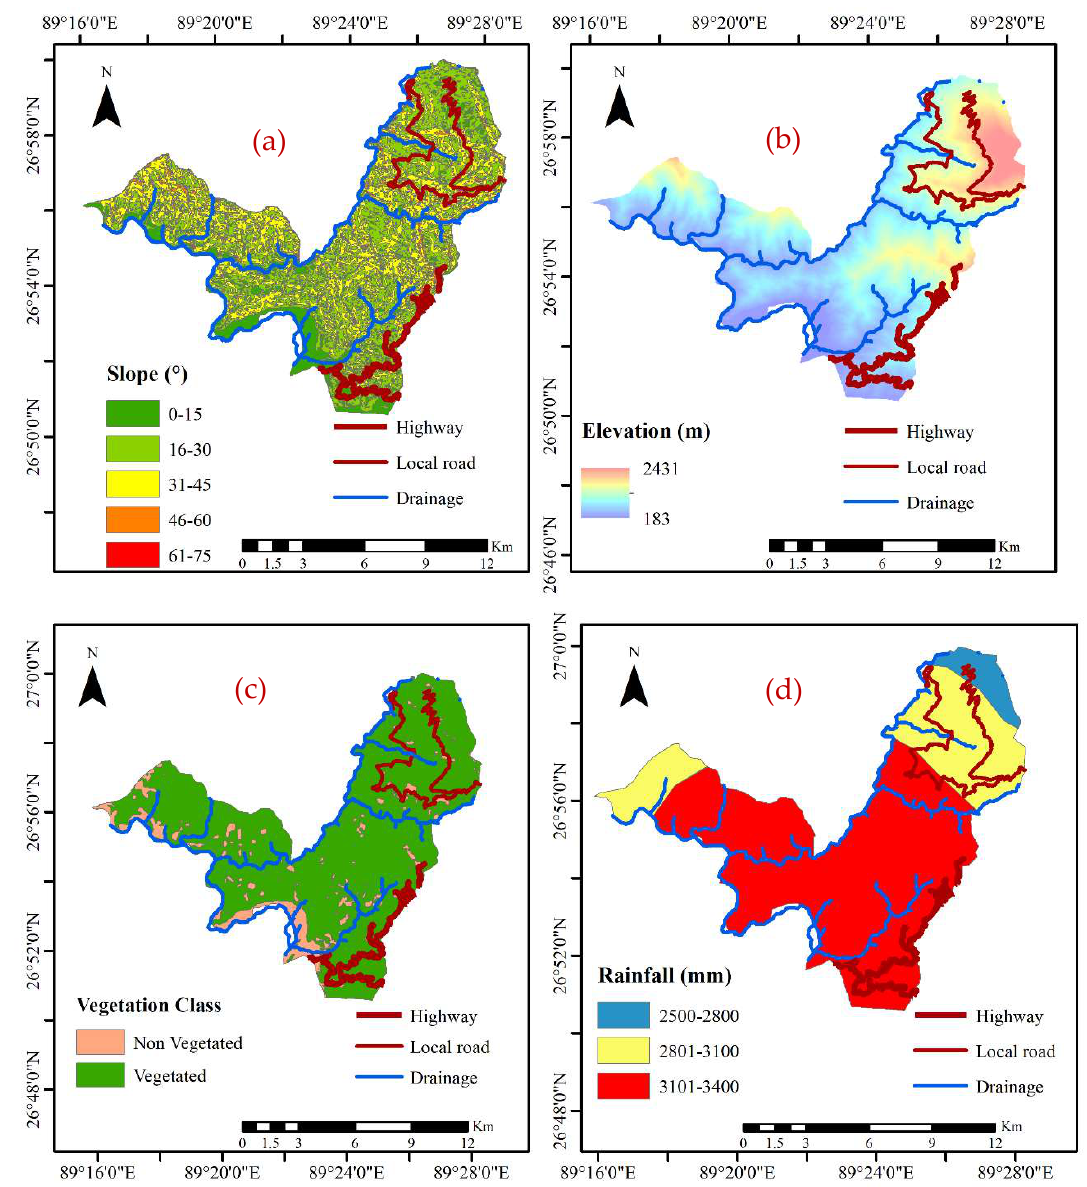
Figure 4. ( a ) Slope, ( b ) elevation, ( c ) vegetation, and ( d ) rainfall map of the study area.